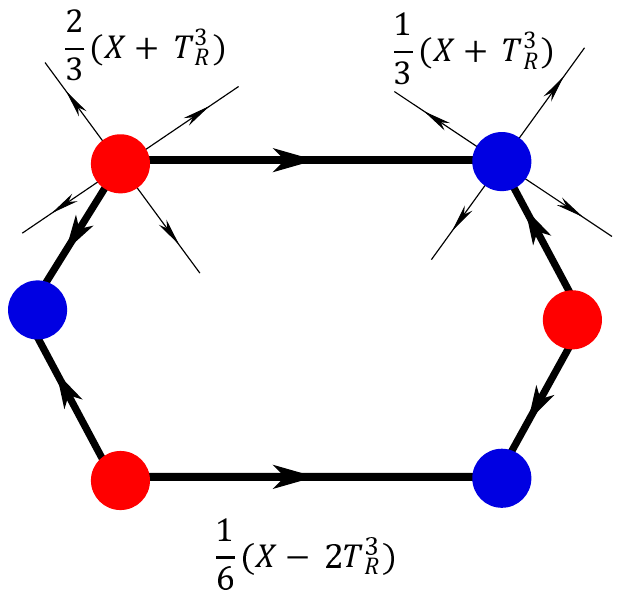
Figure 2 . Necklace with SU(4) c and SU(2) R monopoles from the symmetry breaking SU(4) c SU(2) L SU(2) R SU(3) c U(1) B − L × → ×